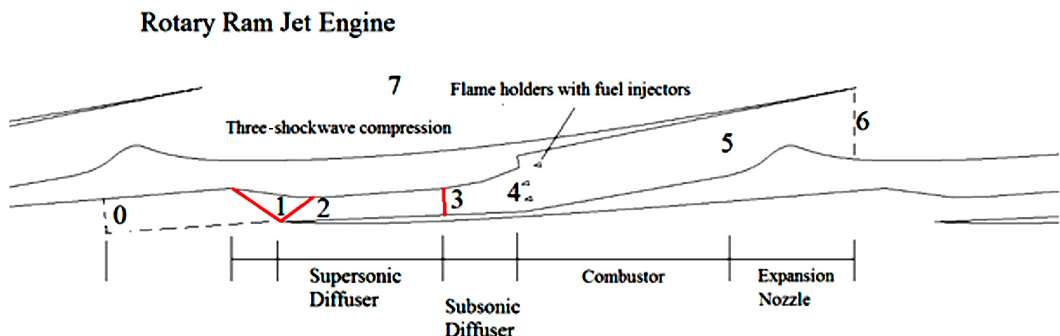
Figure 4. Characteristic areas and cross-sections of the main rotor of a rotary ram jet engine. Markers: 0—define the external conditions, 1—area behind primary oblique wave, 2—area behind secondary oblique wave, 3—area behind the normal shock wave, 4—combustion chamber inlet, 5—nozzle inlet, 6—nozzle outlet.